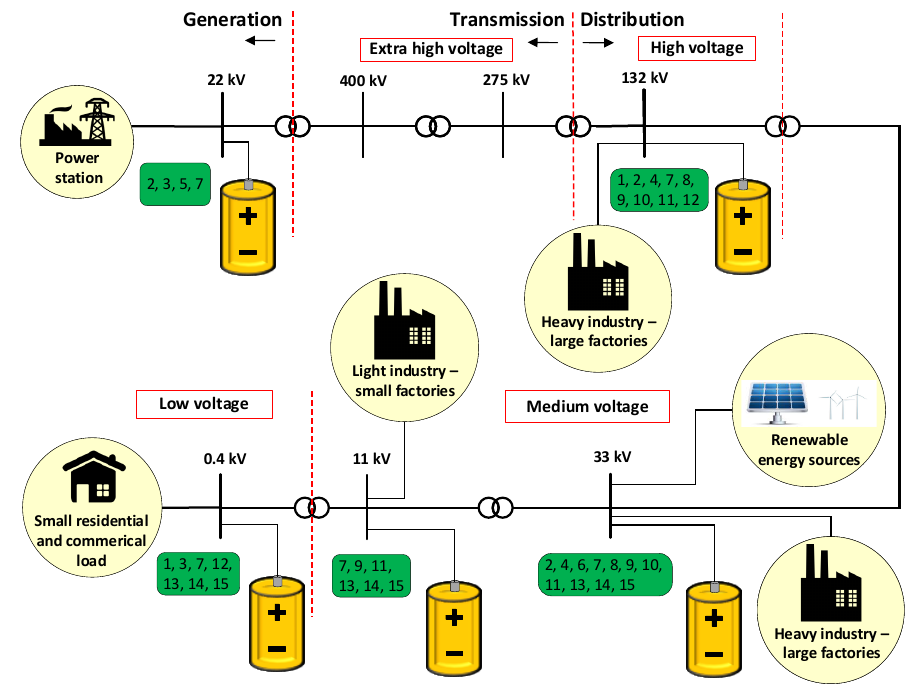
Figure 6. Location of each application of BESSs in the electricity supply